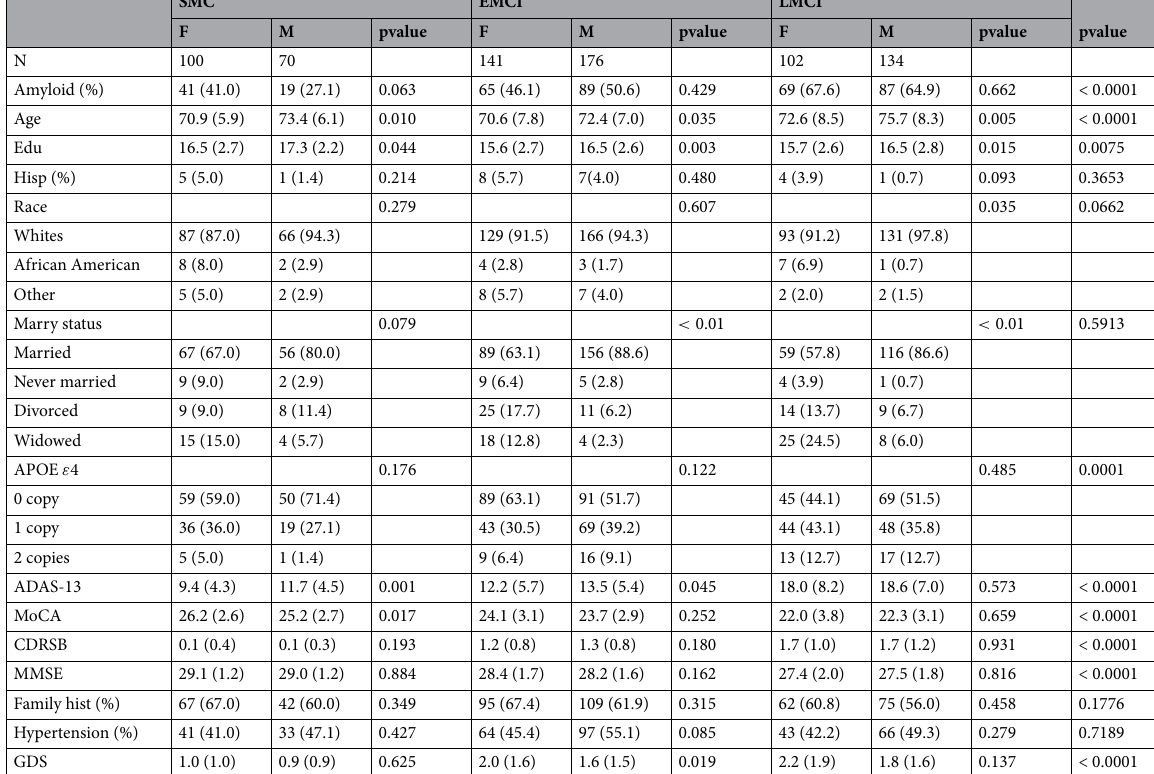
Table 2. Characteristics of the 6 subgroups from the ADNI. The pvalues in the last column are for the difference between the three groups (SMC, EMCI, and